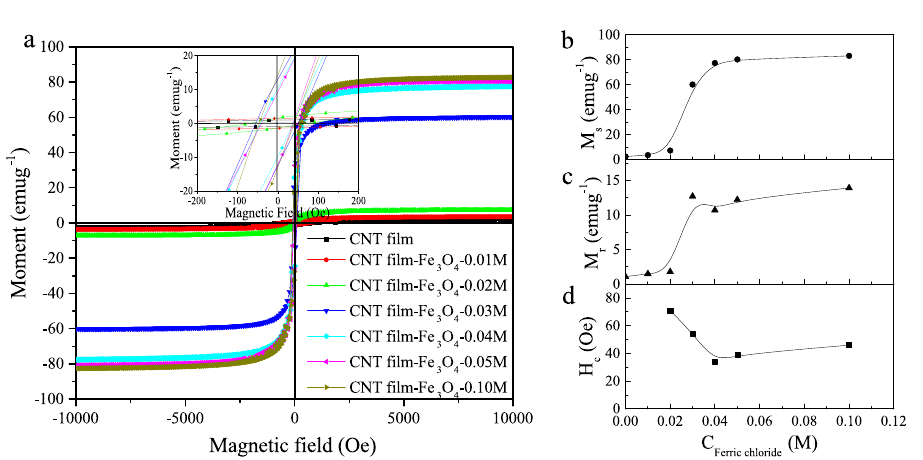
Figure 2. ( a ) XRD patterns of CNT film-Fe 3 O 4 composite. ( b ) EDS pattern of CNT film-Fe 3 O 4 -0.05 M composite.